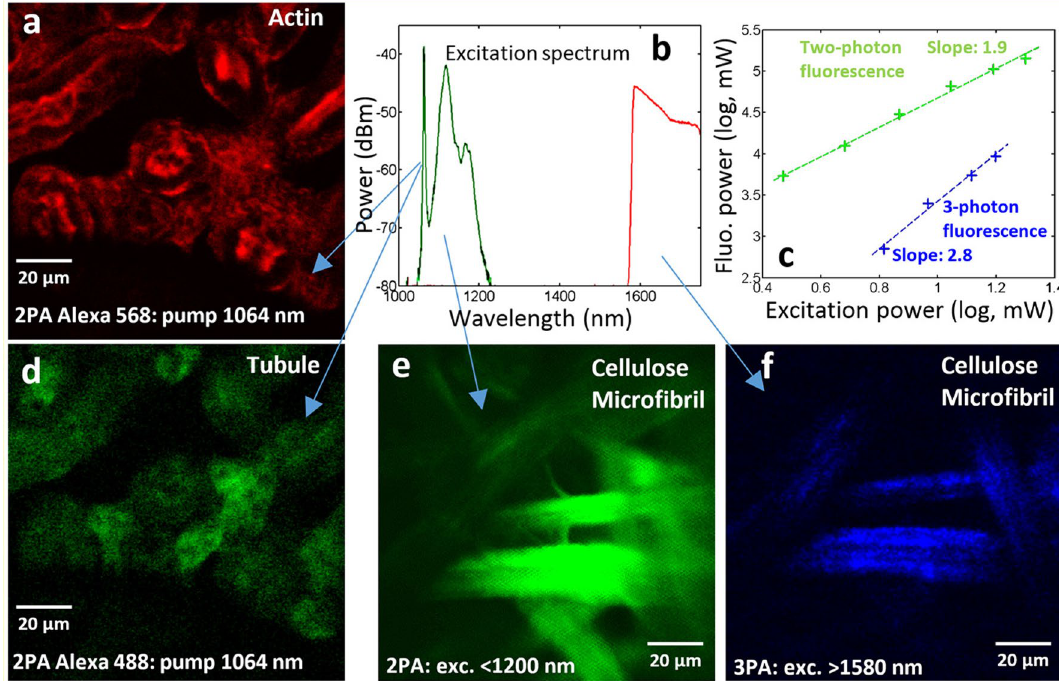
Figure 5. NF images, obtained in endoscopy configuration, of mouse kidney labelled with Alexa 488 and Alexa 568, revealing tubule and actin. 2PA fluorescence images of actin ( a ) and tubule ( d ) by using the self-cleaned pump beam at 1064 nm. ( e ), ( f ) 2PA and 3PA fluorescence images of cellulose microfibril. ( b ) Output spectrum used for experiments. ( c ) Fluorescence evolution versus input peak